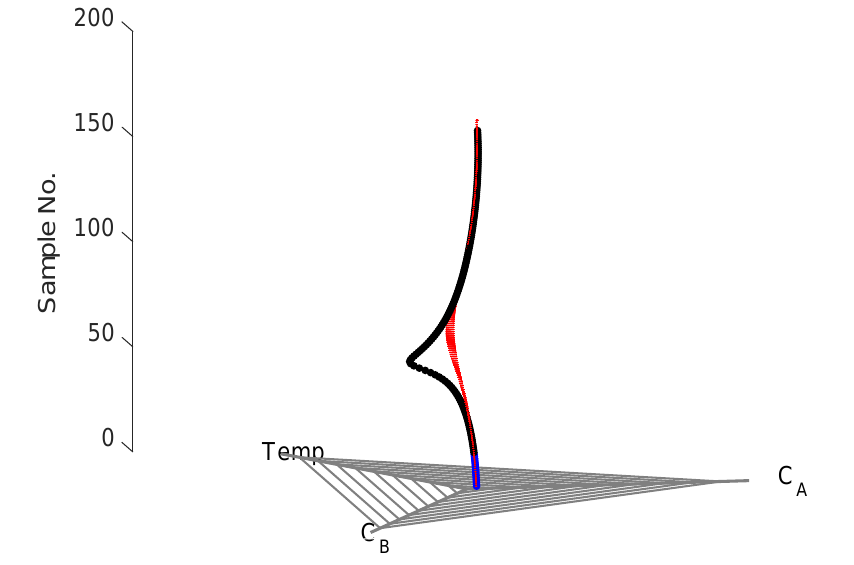
Figure 9. Intra-cycle fault detection is carried out on a problematic cycle. Each sample in the problematic cycle is compared against the intra-cycle confidence region (in red); samples that lie inside the region are colored in blue, whereas samples that lie outside the confidence region are colored in